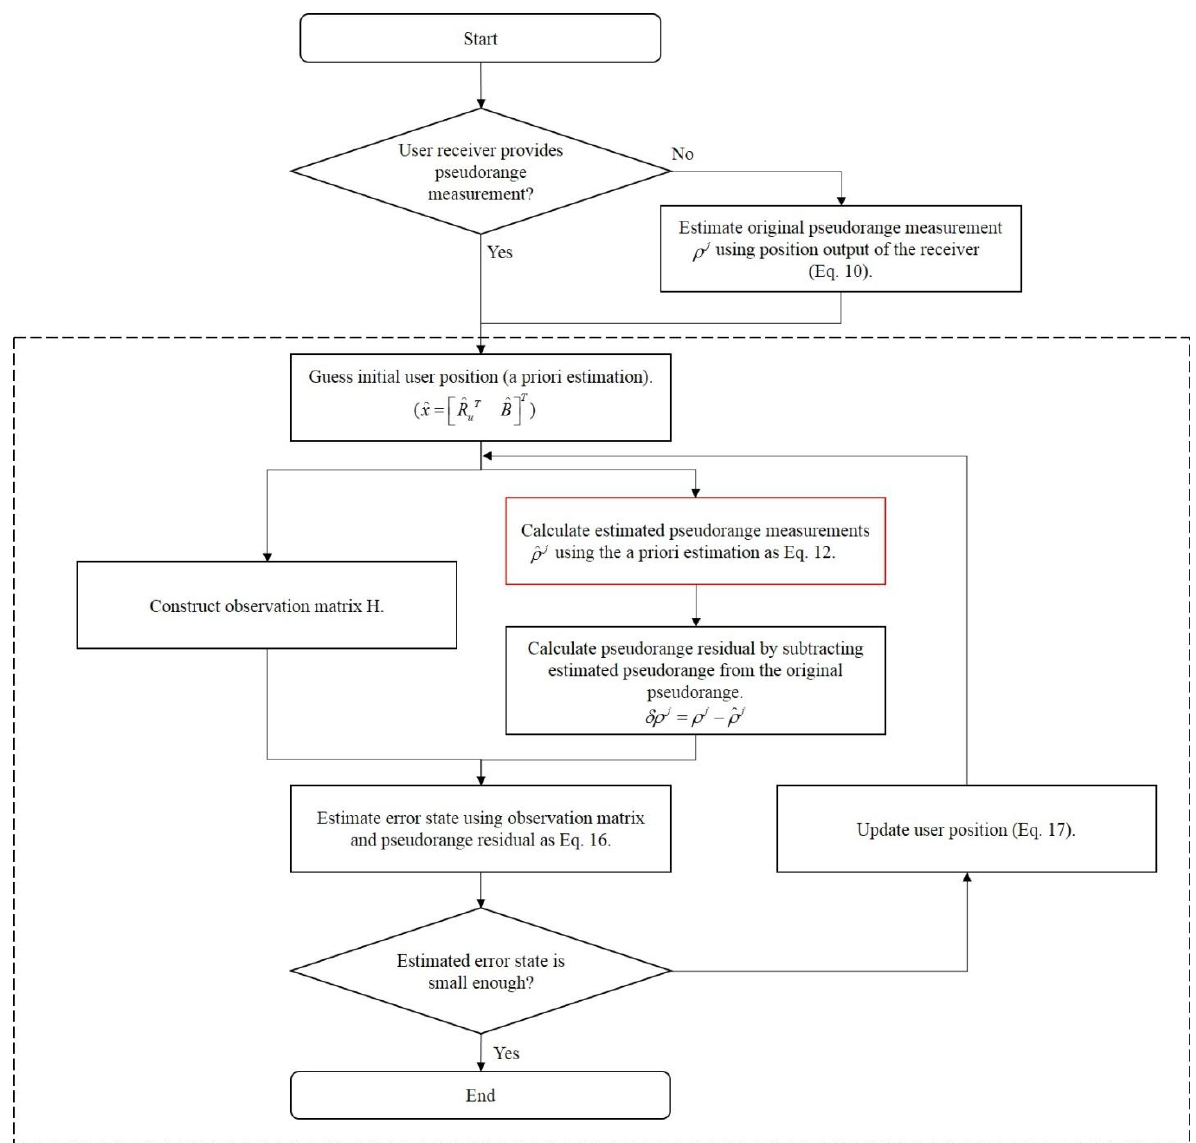
Figure 8. Algorithm for the Final Estimation of the User